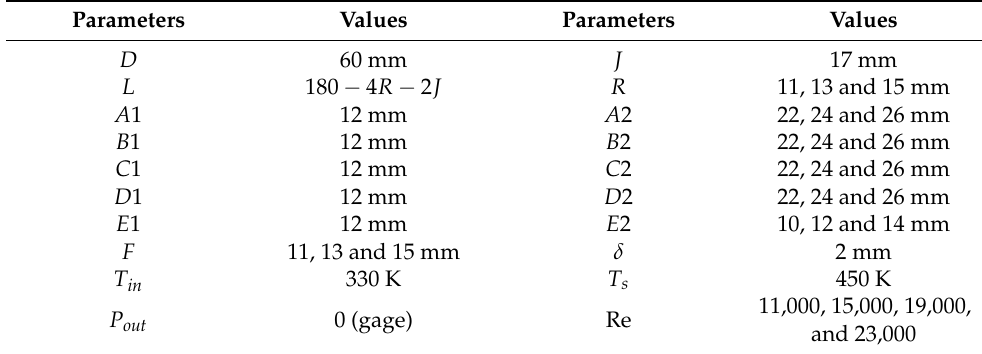
Table 1. Boundary conditions and geometrical data.